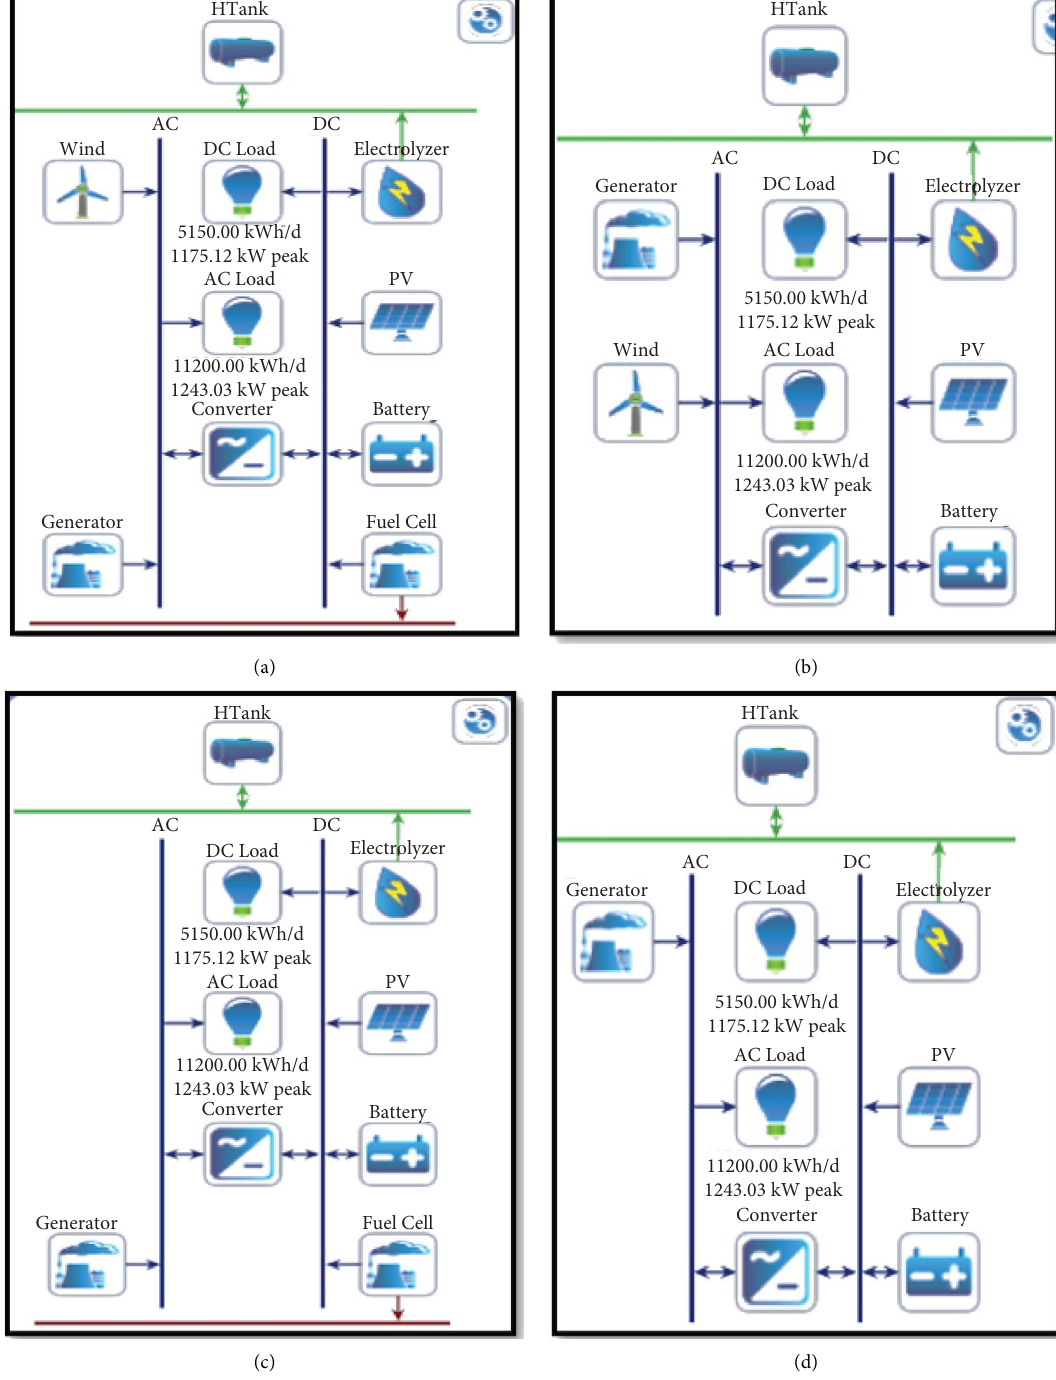
Figure 10: Proposed HRES. (a) Confguration 1. (b) Confguration 2. (c) Confguration 3. (d) Confguration